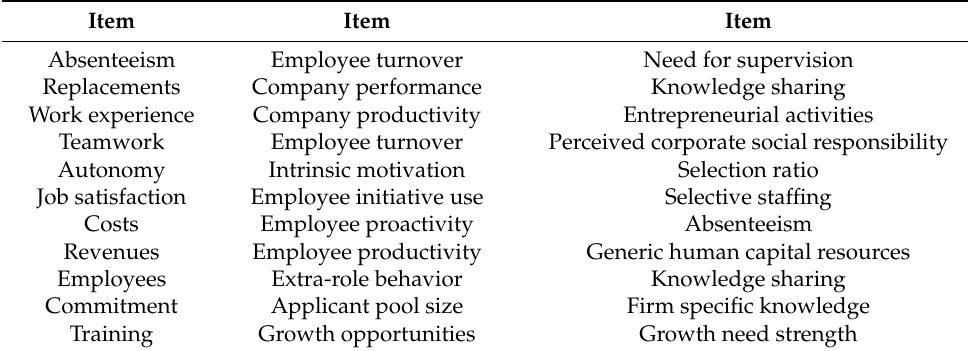
Table 3. Items in Figure 8 on the human resource